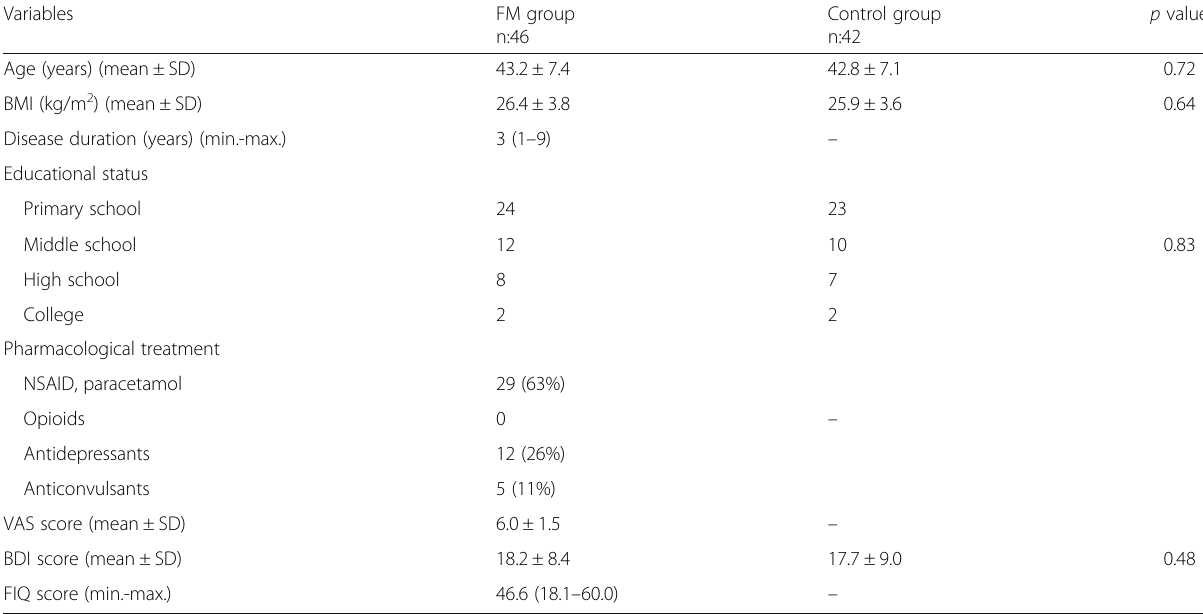
Table 1 Demographic and clinical characteristics of the